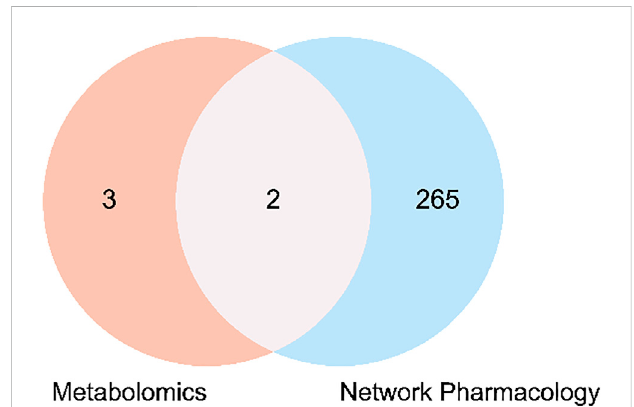
FIGURE 9 Overlapping pathways between metabolomics and network pharmacology